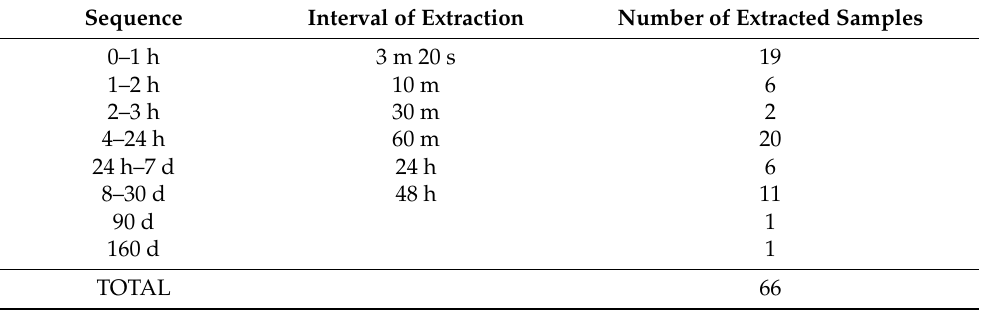
Table 3. Extracted samples from the test